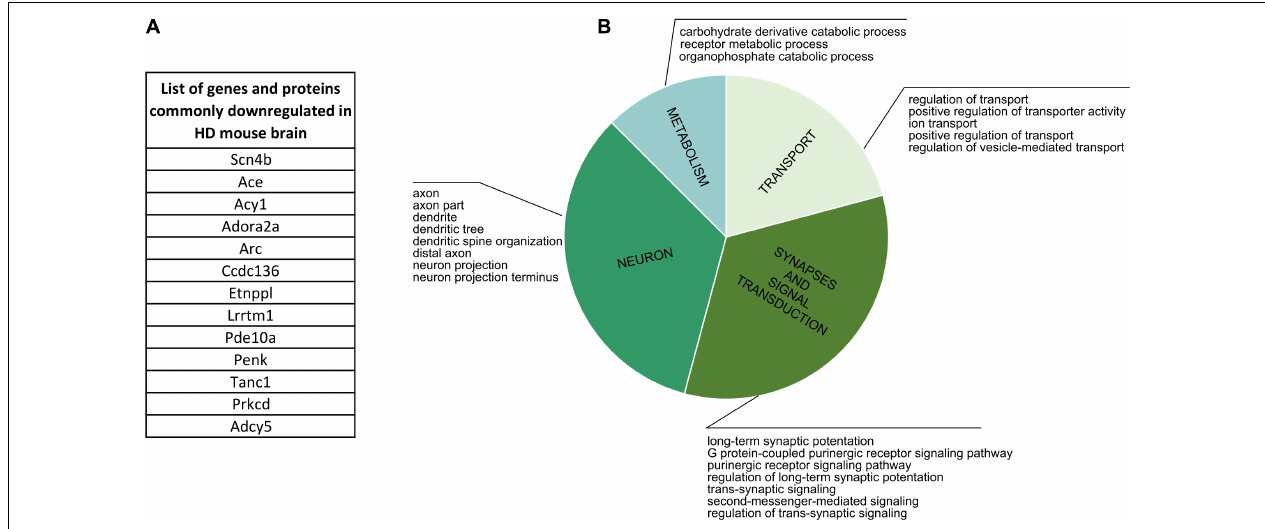
FIGURE 6 | Commonly Downregulated Genes and Proteins in HD Mouse Brain. (A) A list of 13 genes and proteins which were identified as dowregulated in HD mouse brain in several different publications. (B) CPDB GO term over-representation analysis for the identified group of shared genes and